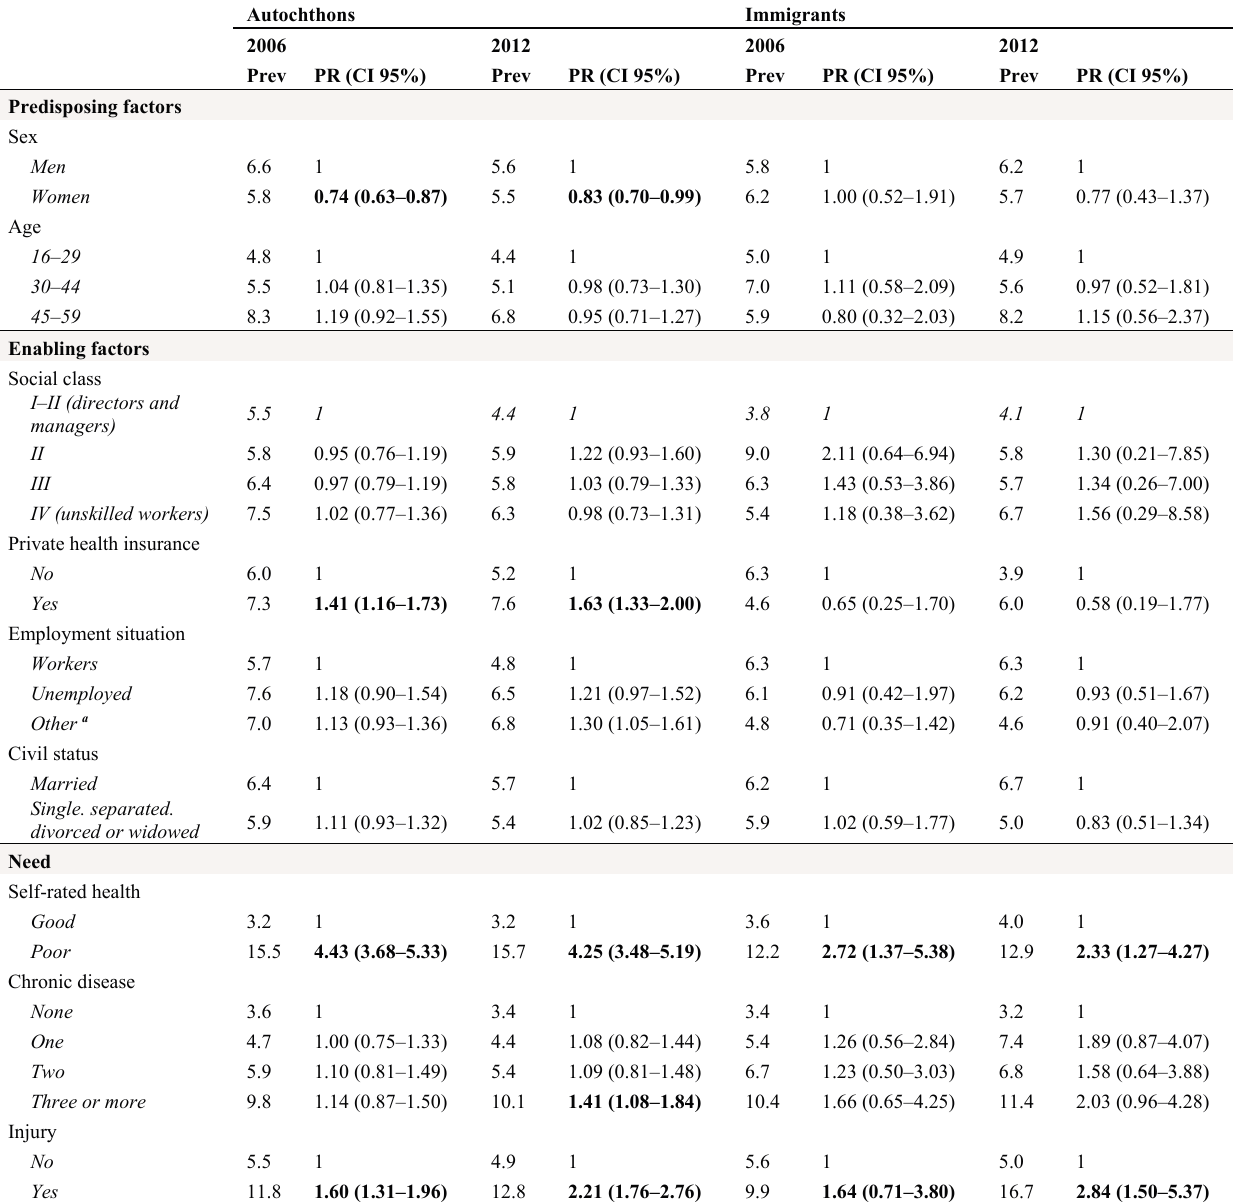
Table 5. Determinants of hospitalization in autochthons and immigrants in 2006 and 2012.